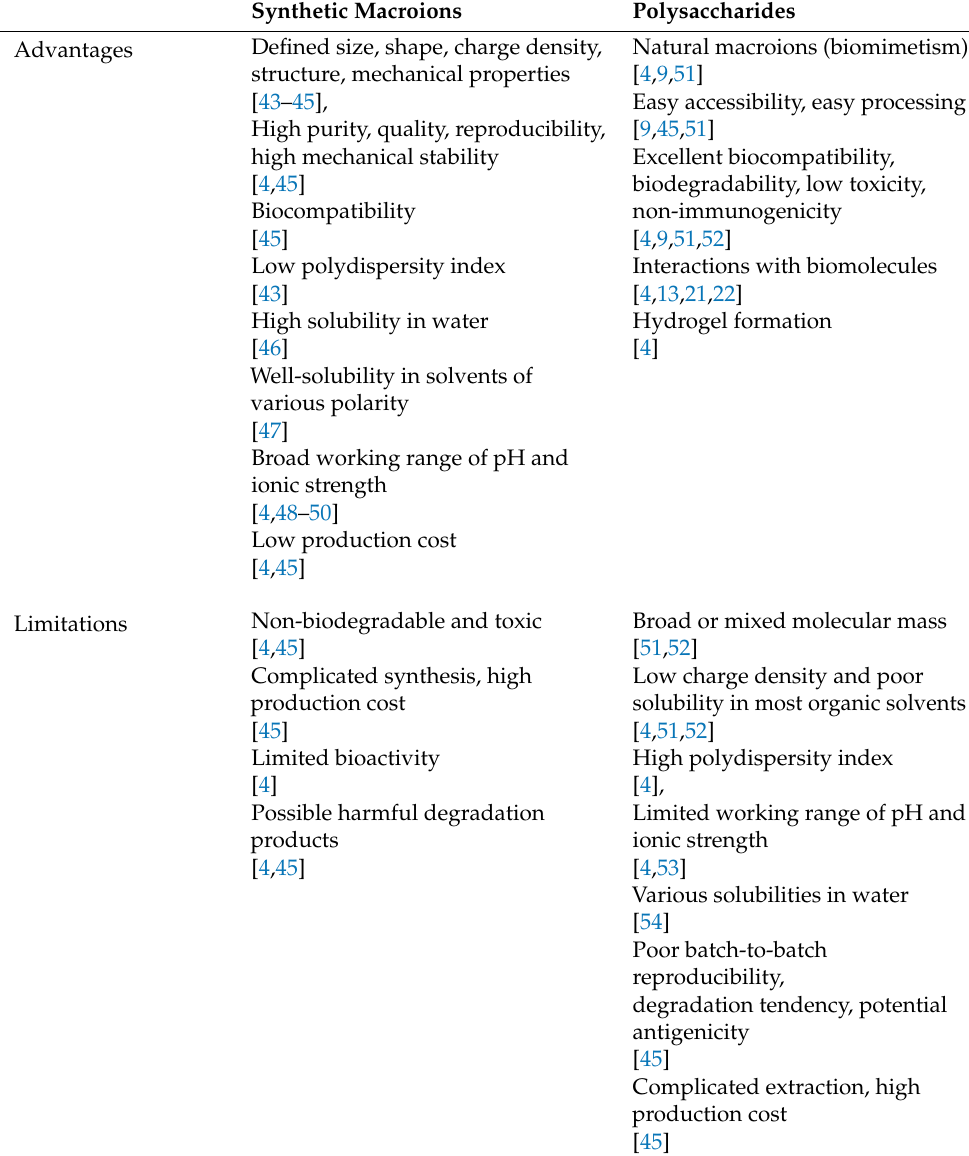
Table 1. The advantages and limitations of macroions for biomedical